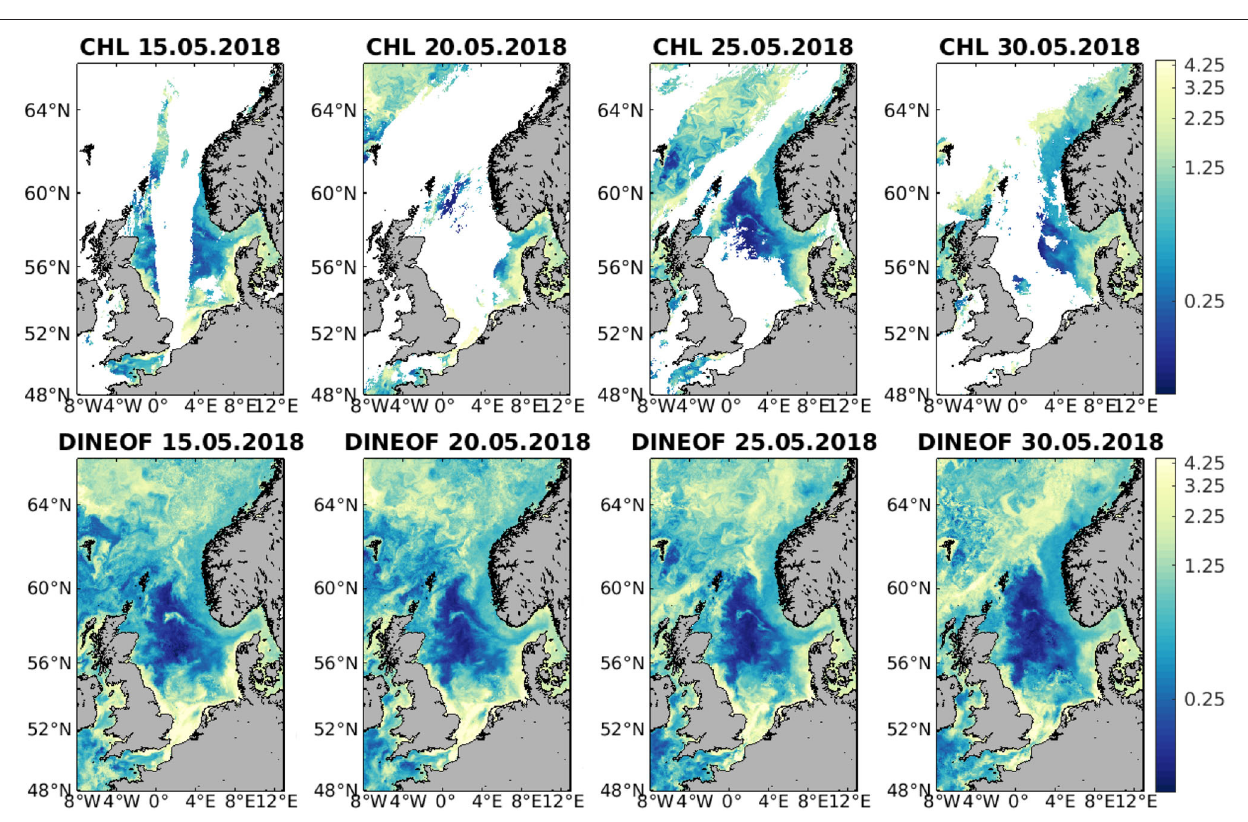
of the spring peak can be observed. The reasons for this interannual variability are numerous, including variations in water temperature, water turbidity and nutrient